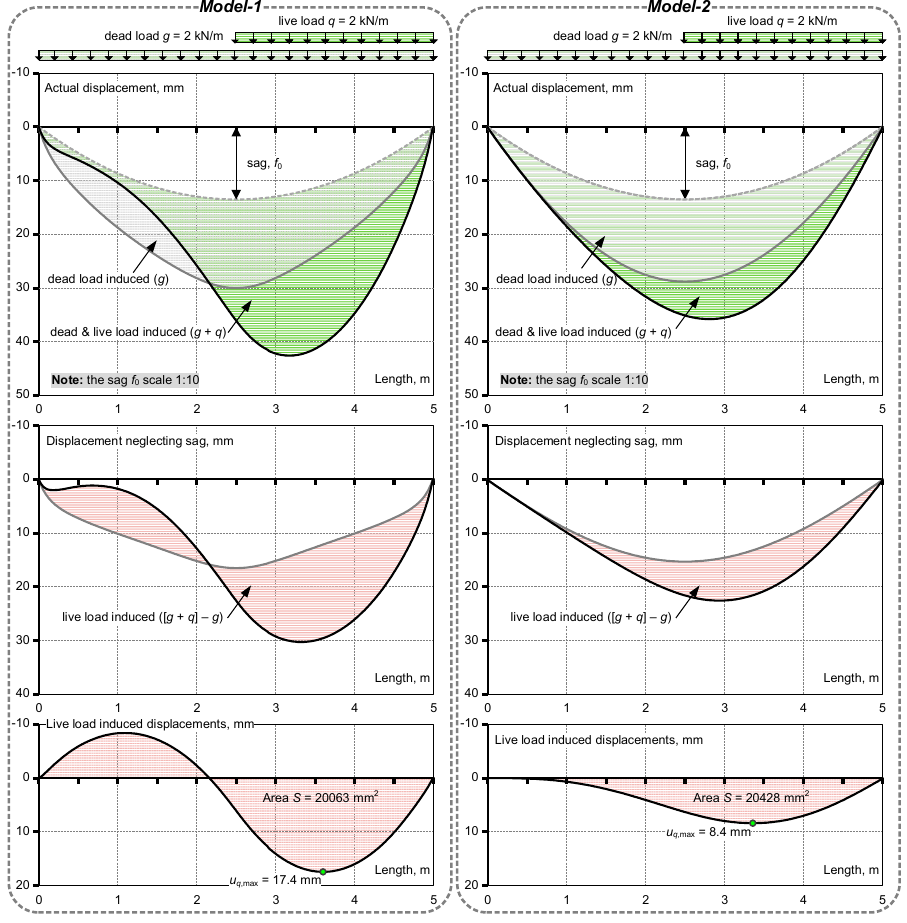
Figure 10. The bridge models’ vertical displacements.